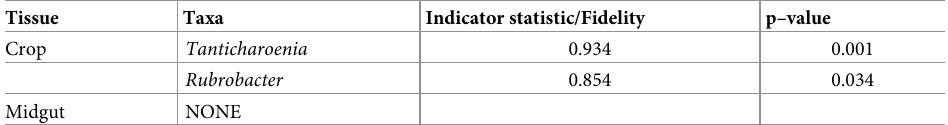
Table 2. ASVs significantly associated with tissue samples as revealed by indicator species analysis.